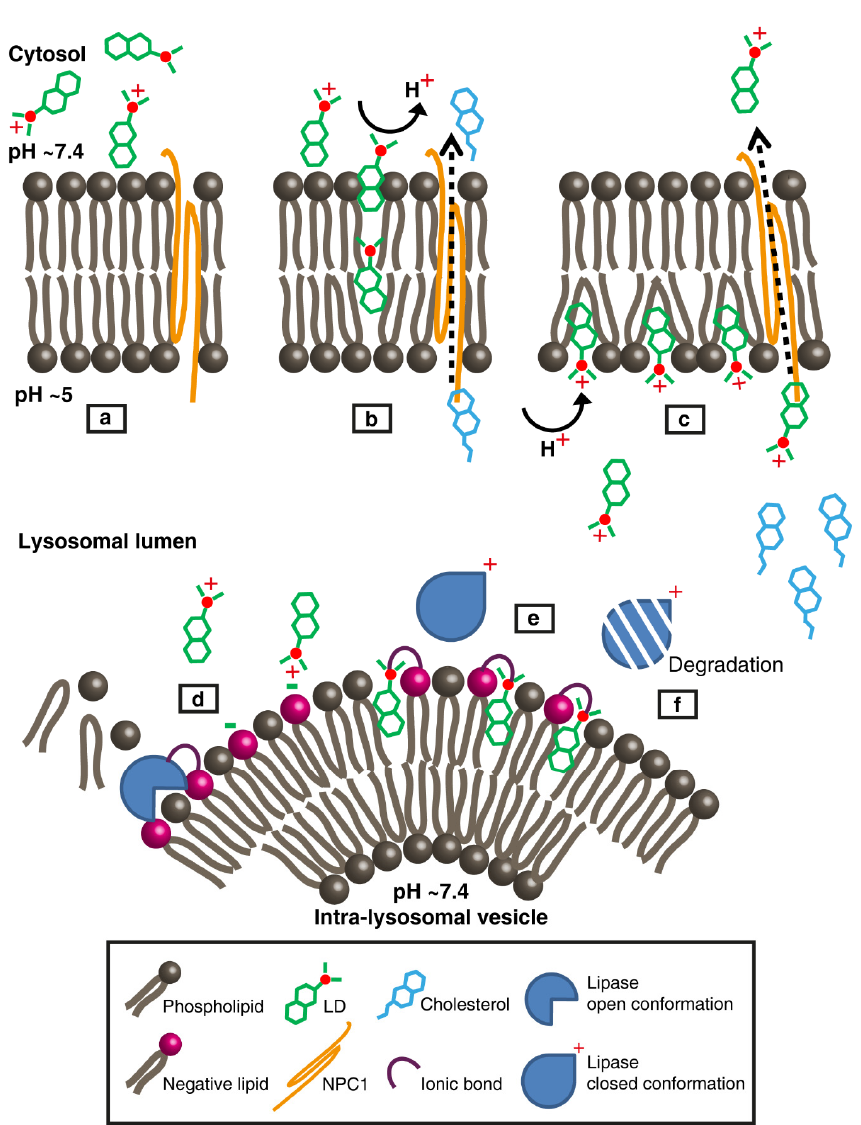
Figure 7. Model representation of lysosomotropic drug accumulation within the lysosomal membranes and its lysosomotropic effects. ( a ) A lysosomotropic drug (LD) reaches the lysosomal outer leaflet surface in its protonated form. The lysosomal limiting membrane (LLM) is illustrated with neutral phospholipids (e.g., phosphatidylcholine and sphingomyelin) and the transmembrane protein Niemann-Pick C1 (NPC1). For simplicity, the lysosomal glycocalyx is not shown. ( b ) The hydrophobic nature of the LD promotes its insertion into the bilayer, during which it undergoes complete deprotonation. Under physiological conditions, NPC1 exports cholesterol to the cytosol. ( c ) LD molecules diffuse through the LLM until their amine residues encounter the acidic lysosomal lumen, where they undergo protonation. As more LD molecules accumulate, they induce enhanced bilayer fluidity, thus enhancing NPC1 activity and competing with cholesterol for binding to NPC1. While most LD molecules concentrate within the inner leaflet of the LLM above the phospholipid head groups, some detach and move through the aqueous lumen. ( d ) The LD reaches the intra-lysosomal vesicle (ILV) surface, where various lipases (e.g., acid sphingomyelinase (ASM), acid ceramidase (AC) and phospholipase A (PLA)) are electrostatically bound to the membrane’s negatively charged lipids, while degrading their lipid substrates. ( e ) The LD inserts into the ILV’s outer leaflet and electrostatically interacts with negatively charged lipids, thereby abolishing the binding of lipases. ( f ) Lipases, in their closed-inactive form, are more rapidly degraded by luminal proteases. As a result of decreased lipase activity, phospholipids accumulate within the lumen of lysosomes, leading to lipidosis. The latter, along with the accumulation of cholesterol, is the hallmark of drug-induced and hereditary